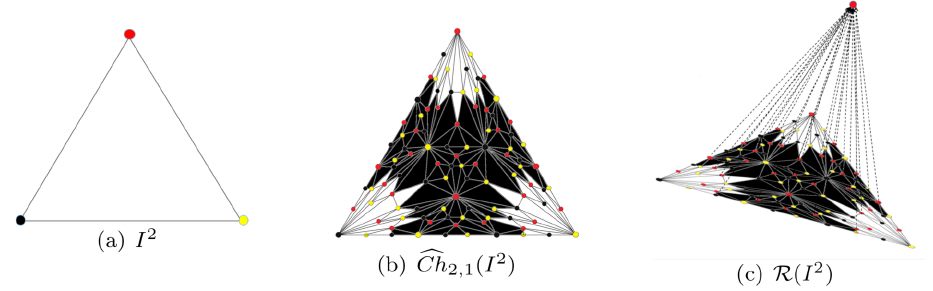
Figure 5. An intuitive procedure of 2-simplex I 2 to some reduced delayed